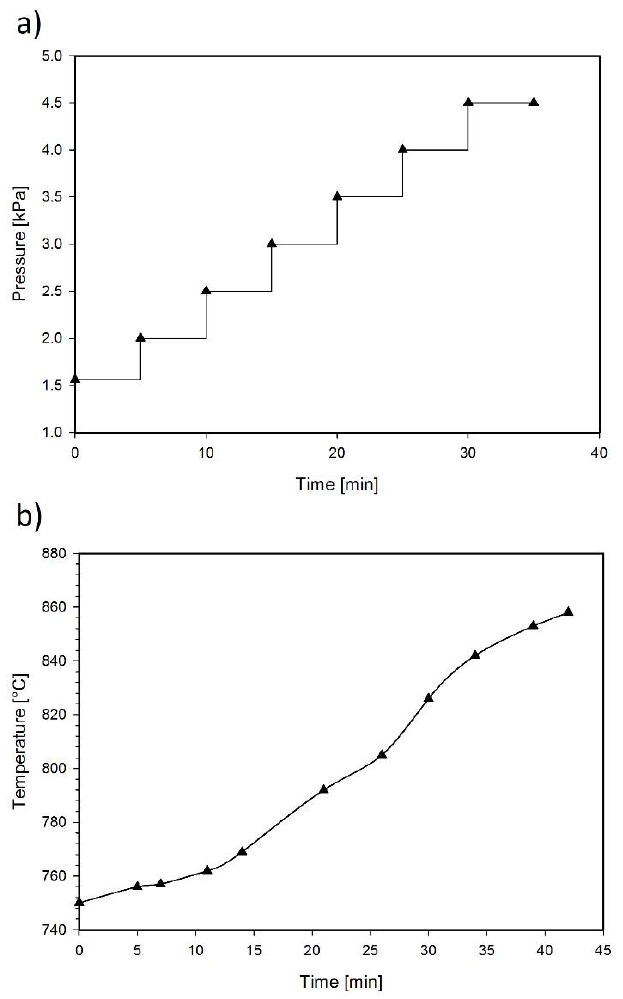
Figure 1. Stepwise variations of ( a ) pressure and ( b ) temperature during the low-pressure chemical vapor deposition (LP-CVD) deposition of the p- and T-coating , respectively.